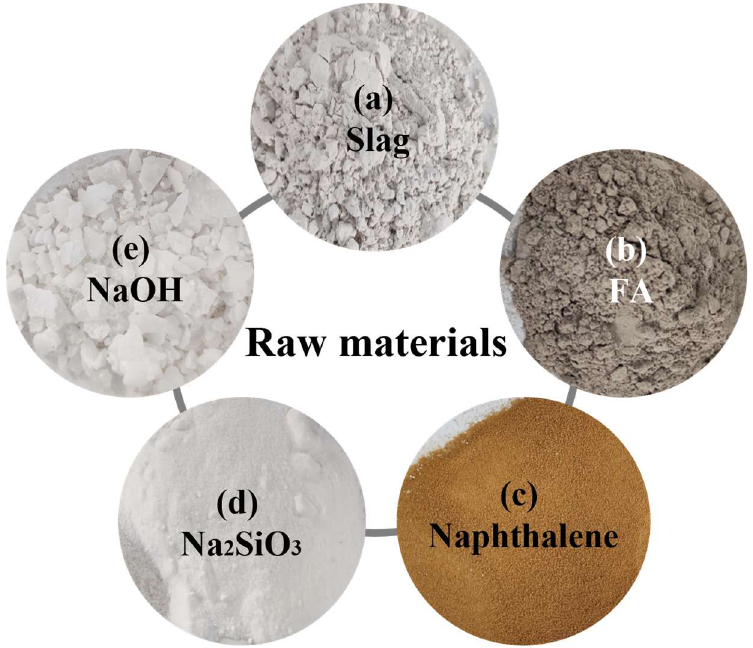
Table 4. Technical index of Na 2 SiO 3